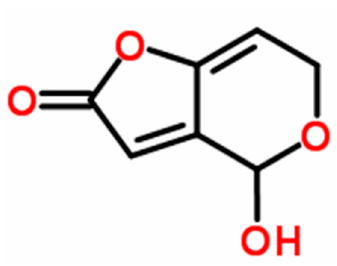
Figure 1. Structural formula of PAT (C 7 H 6 O 4 ).